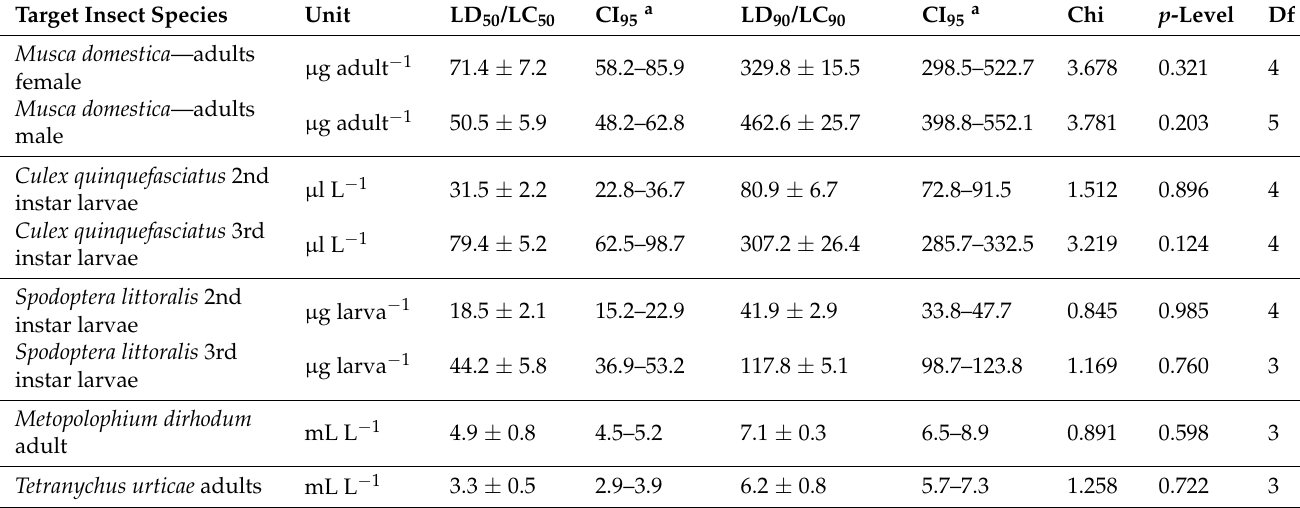
Table 2. Insecticidal and acaricidal activity of Mentha aquatica essential oil against target arthropod pests and vectors.